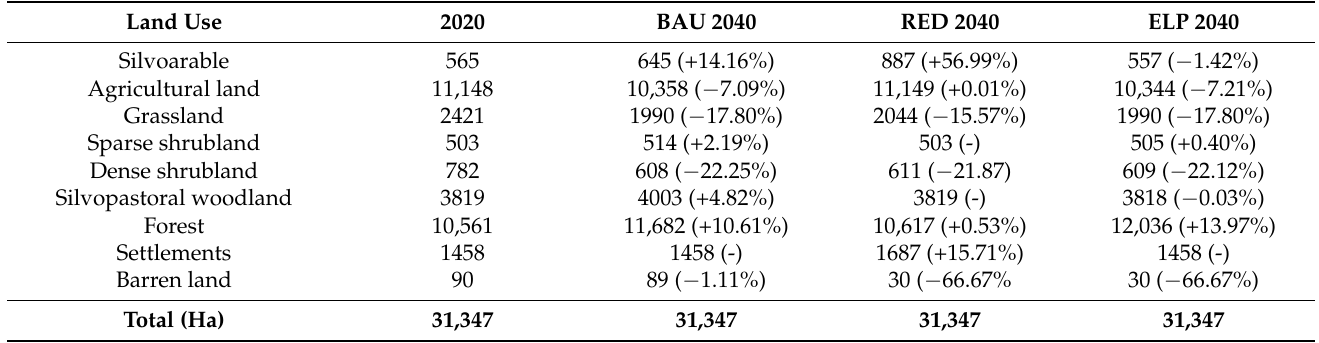
Table 5. Area distribution (Ha) and rate of change (%) of land use units of Mouzaki for the period 2020–2040 for all socio-economic scenarios (BAU, RED,